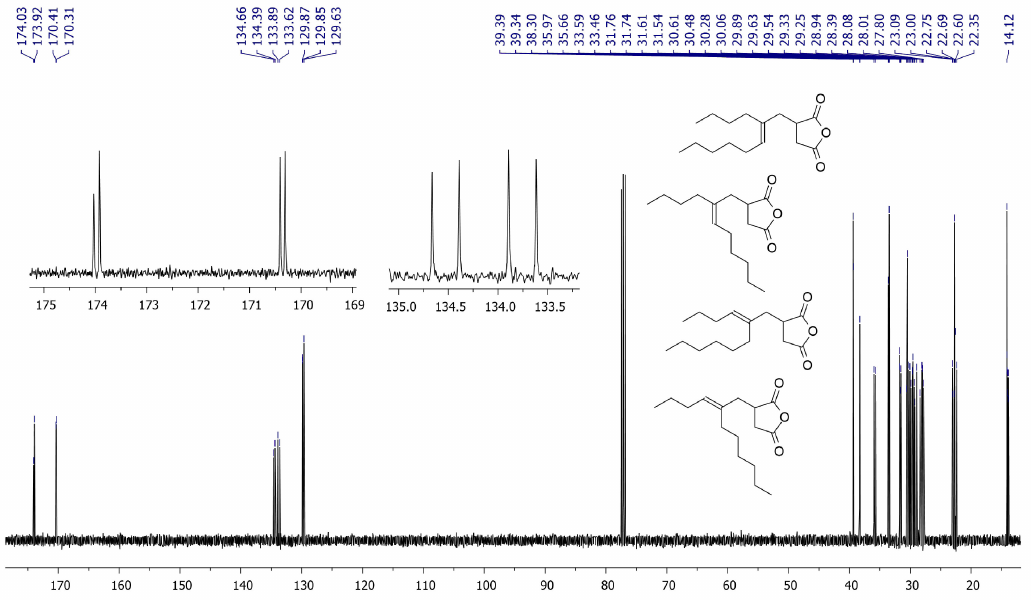
Figure 4. 13 C NMR spectrum (CDCl 3 , 20 ◦ C, 400 MHz) of the products of the Alder-ene reaction between MA and